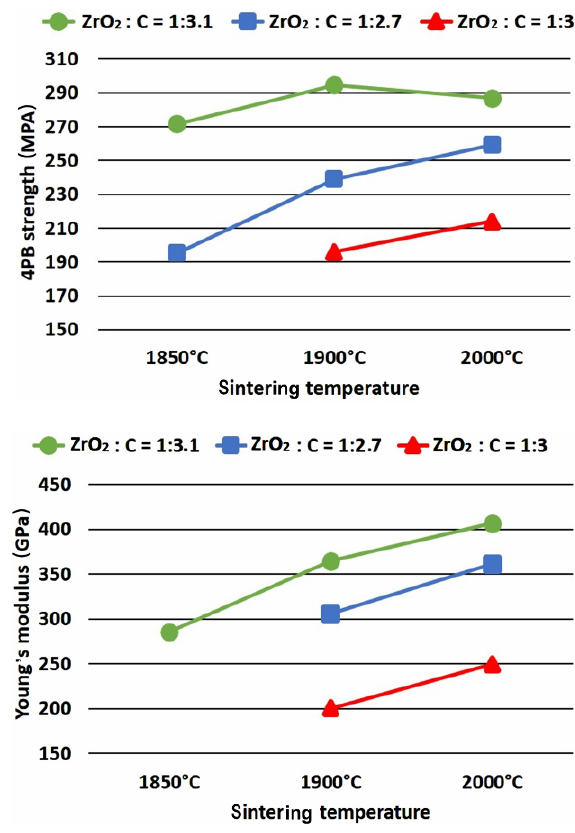
Fig. 9 Young’s modulus (bottom) and 4PB strength (up) of pressureless sintered ZrC material according to sintering